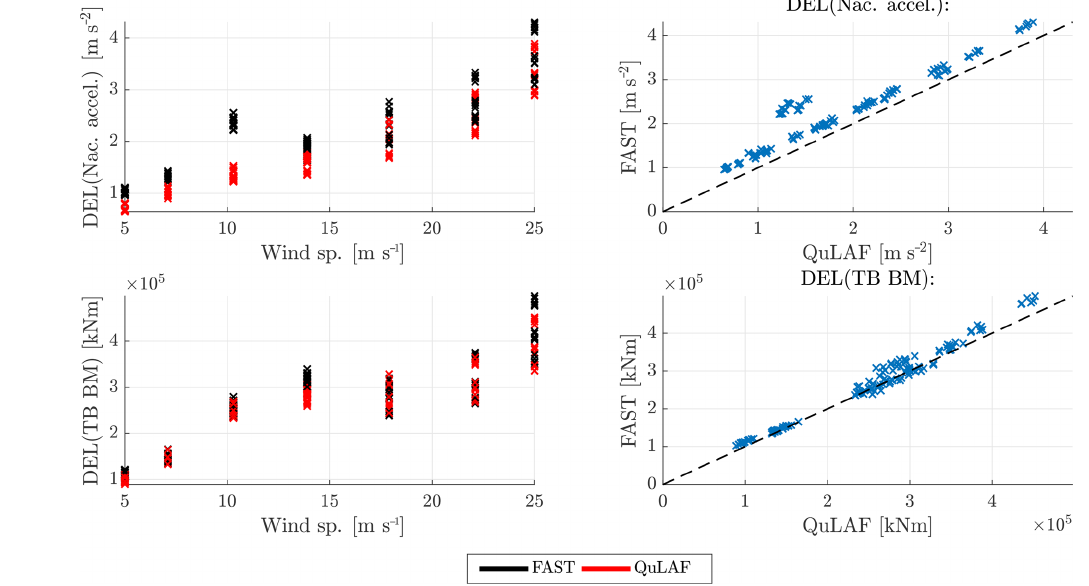
Figure 2. Fatigue damage-equivalent nacelle acceleration and bending moment at the tower base for DLC 1.2.